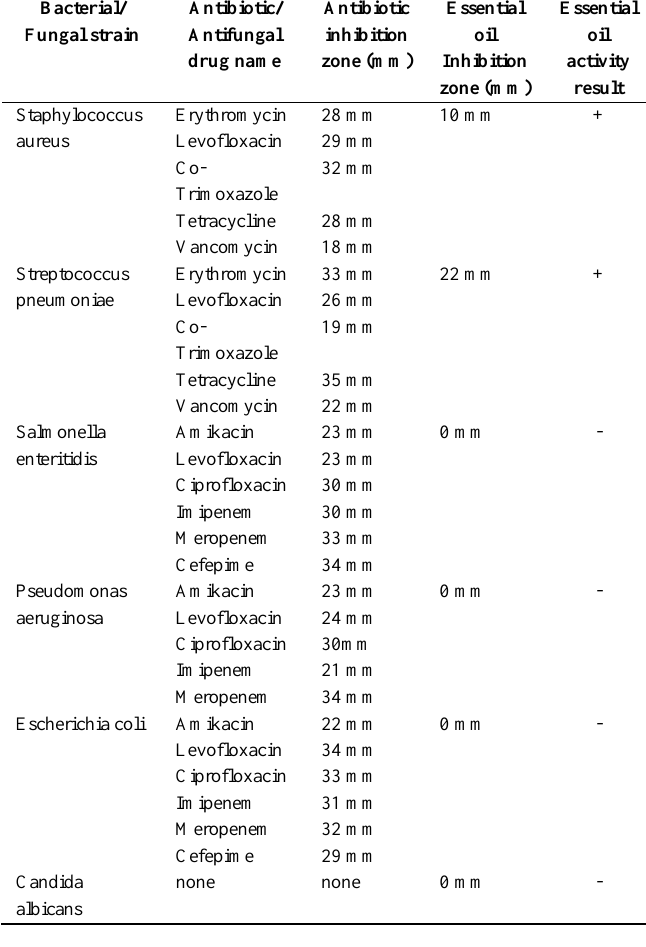
Table 2 : Inhibition zone and results of essential oil antimicrobial activity and antibiotic discs